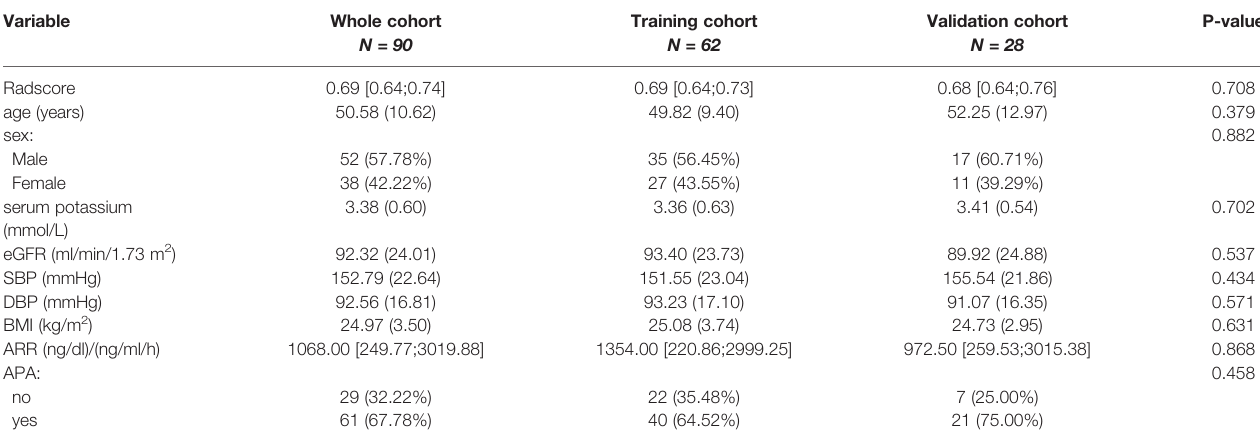
TABLE 1 | Clinical characteristics of the training and validation cohorts.